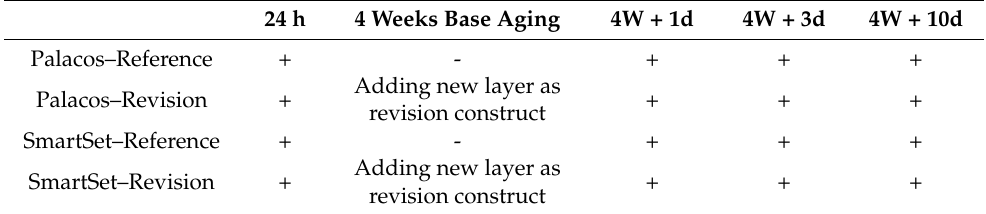
Table 1. Aging times; (+) testing times; (-) no adding/modifications.